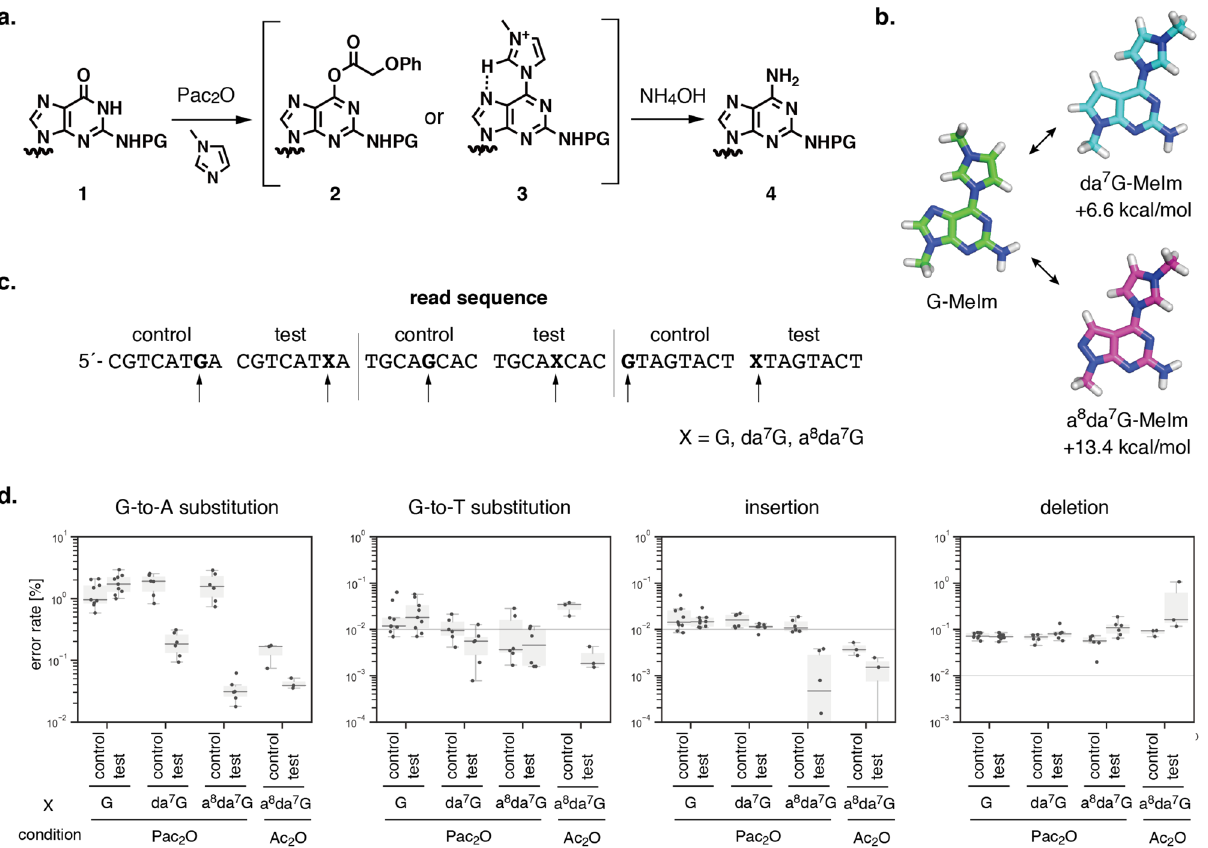
Figure 7. Mechanism of G-to-A substitutions. ( a ) Previously proposed mechanism of diaminopurine formation, which is slightly modified based on this study 19 . ( b ) Optimized structure of the model of intermediates. ( c ) Positions of unnatural nucleosides. ( d ) Observed error rates related to deoxyguanosine. The synthetic conditions for Pac 2 O (n = 2) are 5-benzylthio-1 H -tetrazole in anhydrous acetonitrile as an activator, phenoxyacetic anhydride in THF as a capping reagent A, 10% 1-methylimidazole in 10% pyridine- THF as a capping reagent B, 0.02 M I 2 in THF/pyridine/H 2 O (90:<1:10, v/v/v) as an oxidation reagent, and 3% trichloroacetic acid in dichloromethane (TCA) as a deblocking reagent. The synthetic conditions for Ac 2 O (n = 1) are 1 H -tetrazole in anhydrous acetonitrile as an activator, acetic anhydride in THF as a capping reagent A, 10% 1-methylimidazole in 10% pyridine-THF as a capping reagent B, 0.02 M I 2 in THF/pyridine/H 2 O (90:<1:10, v/v/v) as an oxidation reagent, and 3% trichloroacetic acid in dichloromethane (TCA) as a deblocking reagent. Q5 High-Fidelity DNA polymerase was used for assembling